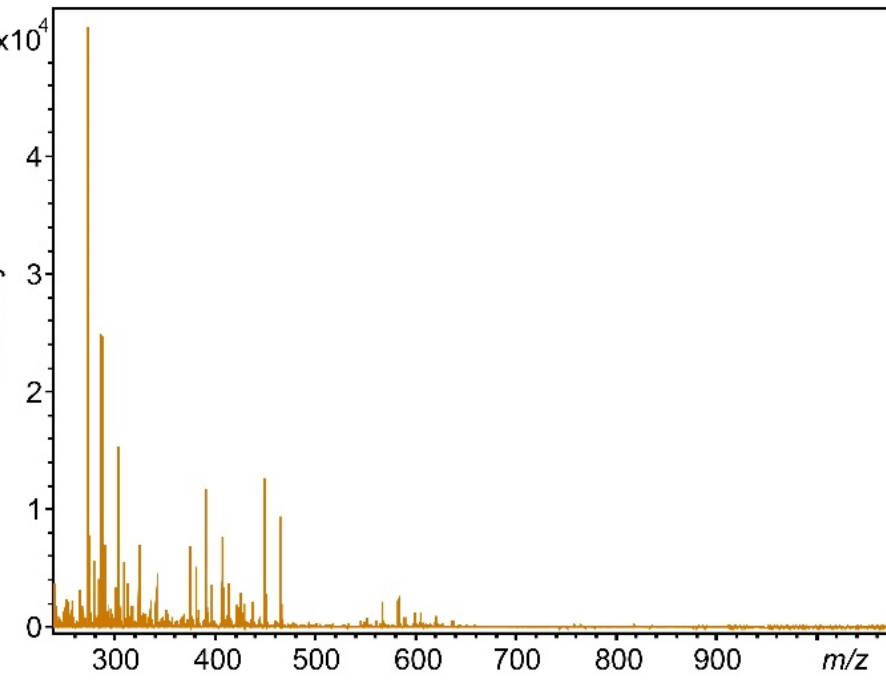
Figure 3. MALDI-TOF spectrum of a pre-dose human urine sample spiked with PEG 400 at 0.900 mg/mL and 50 µL of mPEG. The peaks marked by red symbols denote the mPEG oligomer series.